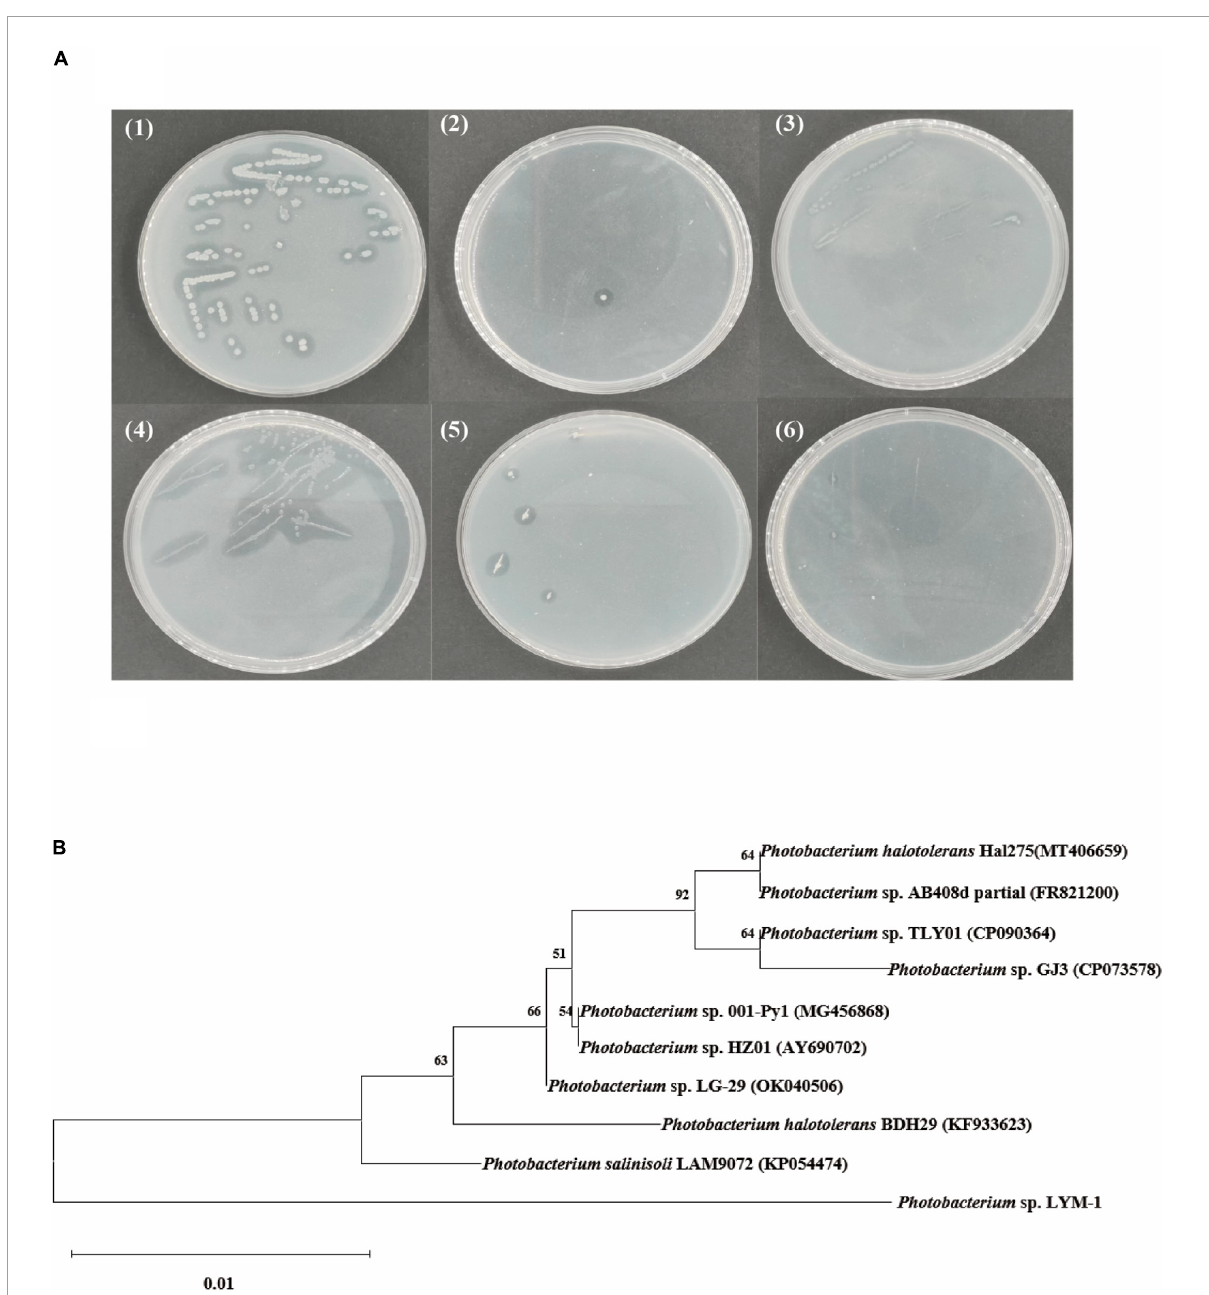
FIGURE1 (A) Screening of strains: (1) Photobacterium sp. LYM-1, (2) Aeromonas sp. ZXY-3, (3) Vibrio sp. WM-1, (4) Rheinheimera sp. ZXY-2, (5) Shewanella sp. ZXY-1, and (6) Pseudomonas sp. LYM-2; (B) neighbor-joining tree based on 16S rRNA gene sequences showing the phylogenetic relationships between strain Photobacterium sp. LYM-1 and its related